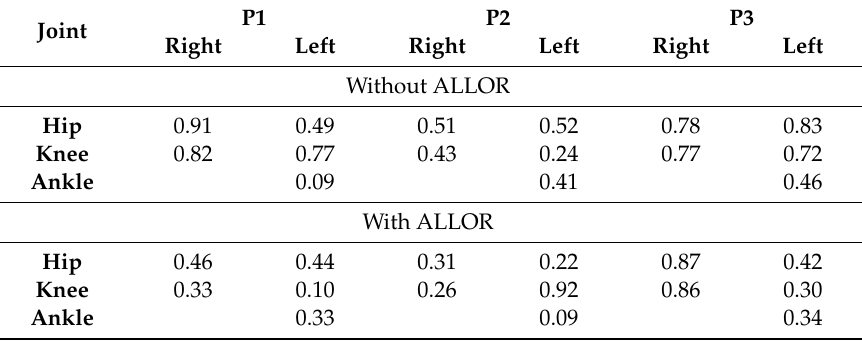
Figure 4. Kinematics patterns of the three post-stroke patients (P1, P2, and P3), obtained from inertial sensors, and compared to control group (C). Table 2. Concordance of joint angular variations into a gait cycle between each post-stroke patient and healthy control